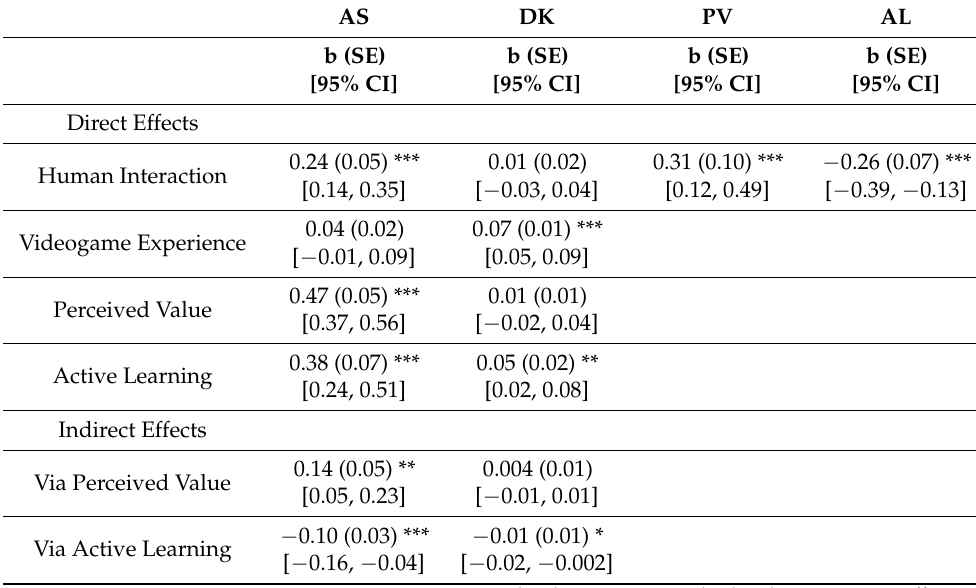
Table 2. Direct and indirect effect